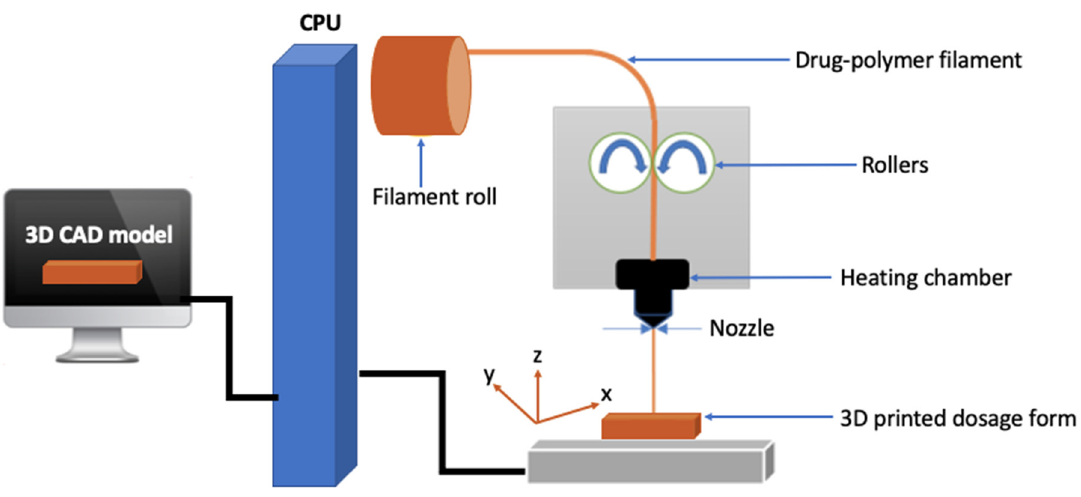
Figure 2. Main features of FDM 3D printing process from computer-aided design to printed dosage form.